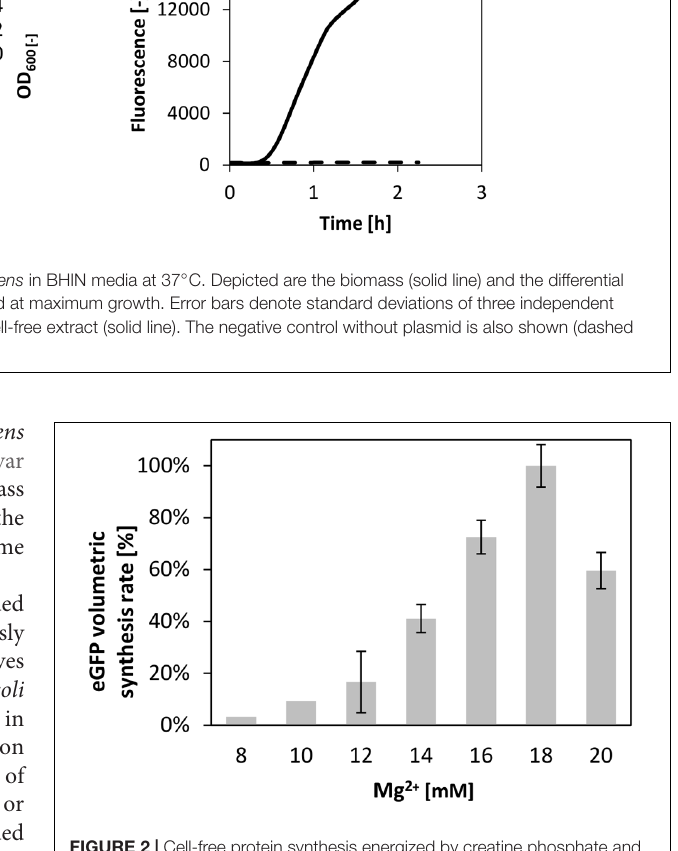
FIGURE 2 | Cell-free protein synthesis energized by creatine phosphate and creatine kinase. Differential rate of eGFP synthesis over time at different magnesium concentrations. The maximum of 100% corresponds to 1.33 ± 0.1 mg eGFP × L − 1 × min − 1 . Error bars represent standard deviations of triplicate